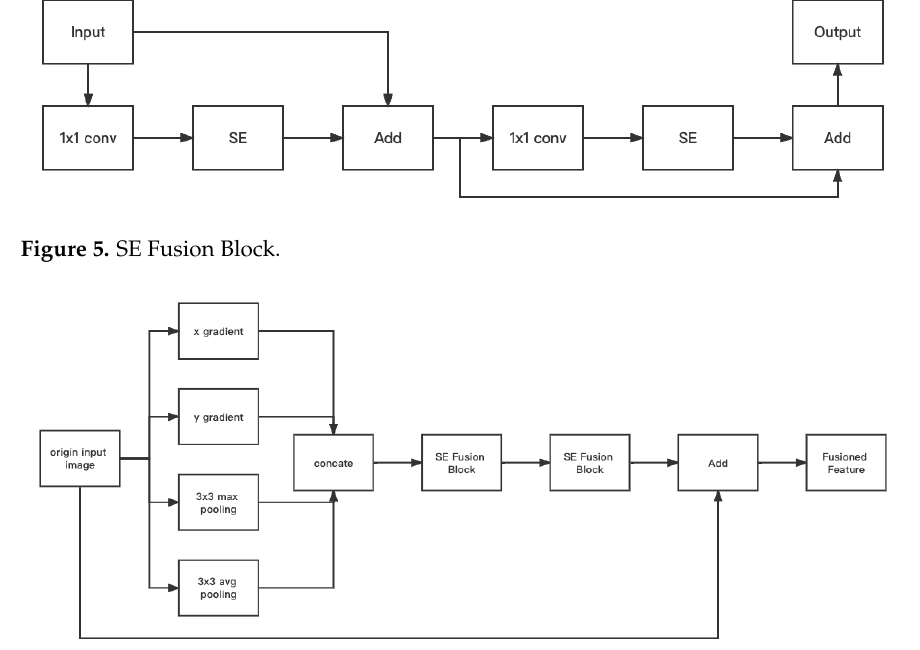
Figure 6. Detail Correction